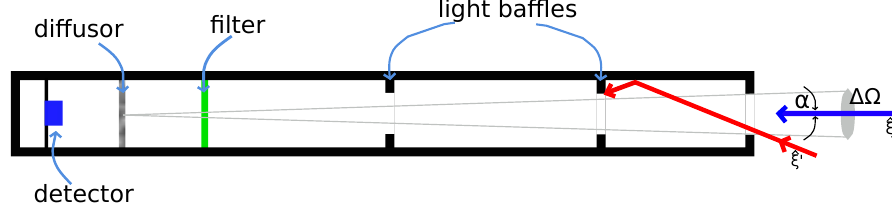
Figure 1. Cross-section of the Gershun tube